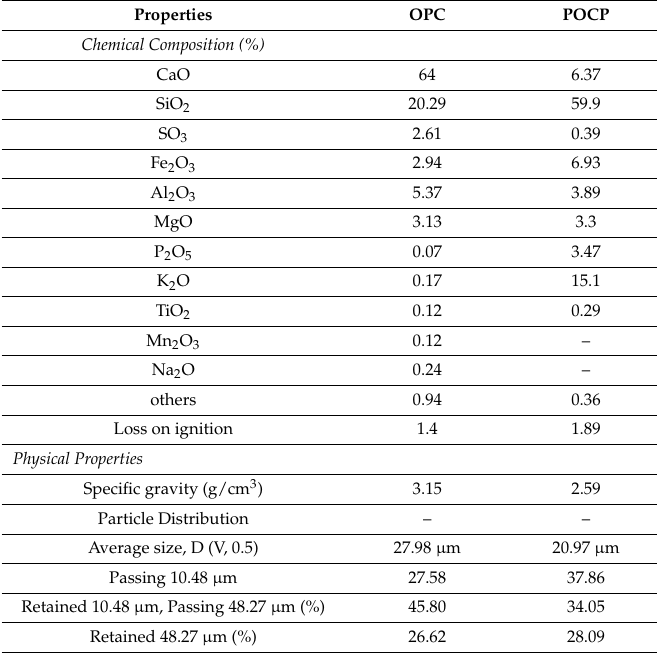
Table 2. Chemical composition and physical properties of Ordinary Portland Cement (OPC) and palm oil clinker powder (POCP) [12].